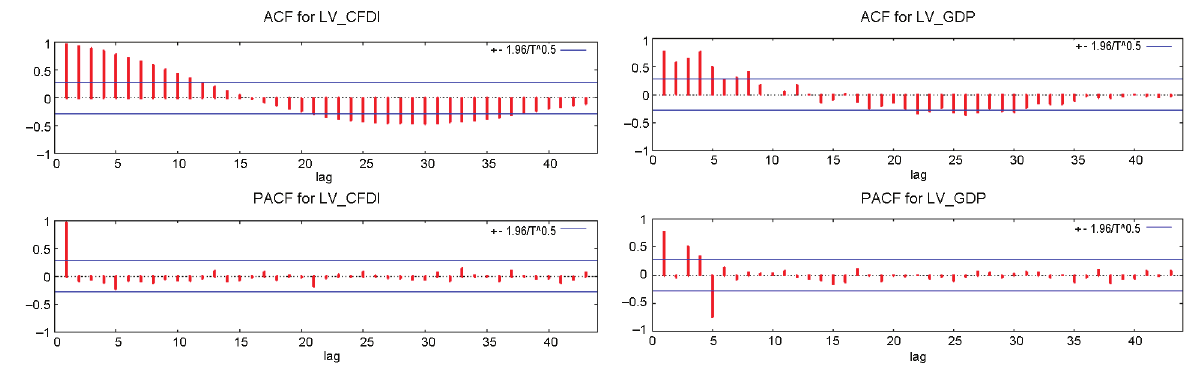
Fig. 8. Plotting the autocorrelation function (ACF) and partial autocorrelation function (PACF) for Latvia’s CFDI and the construction’s contribution to the GDP